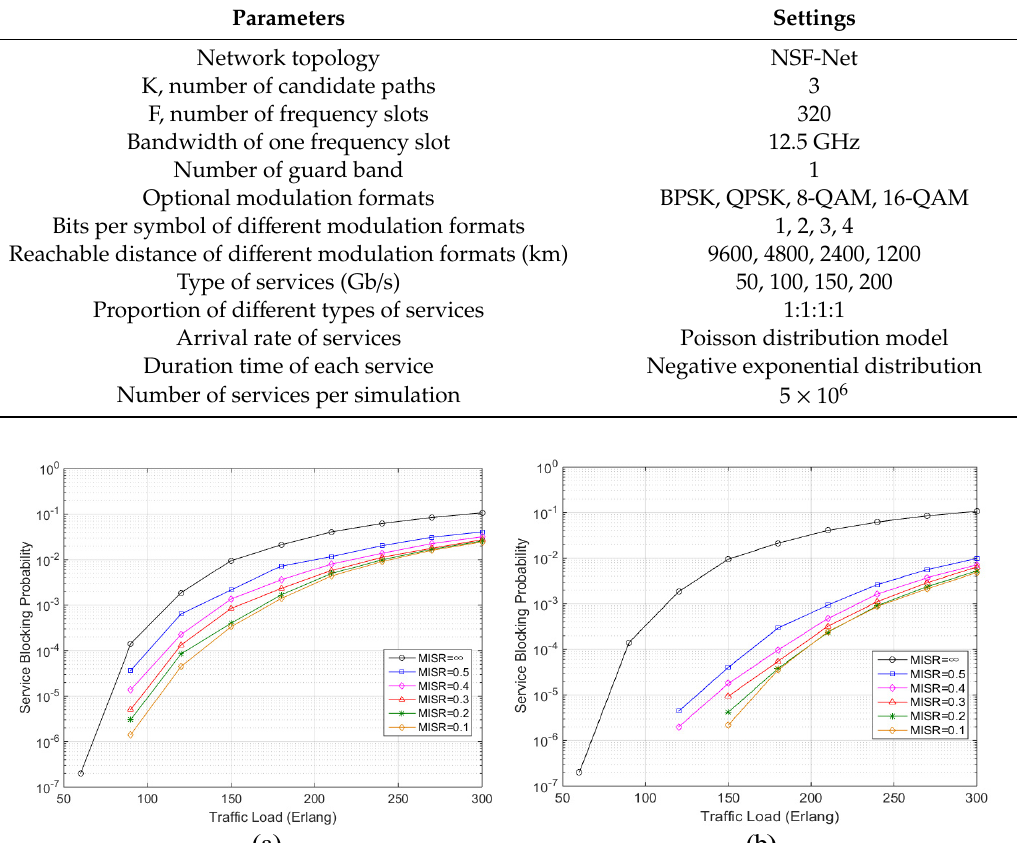
Table 3. Parameter settings in simulations.